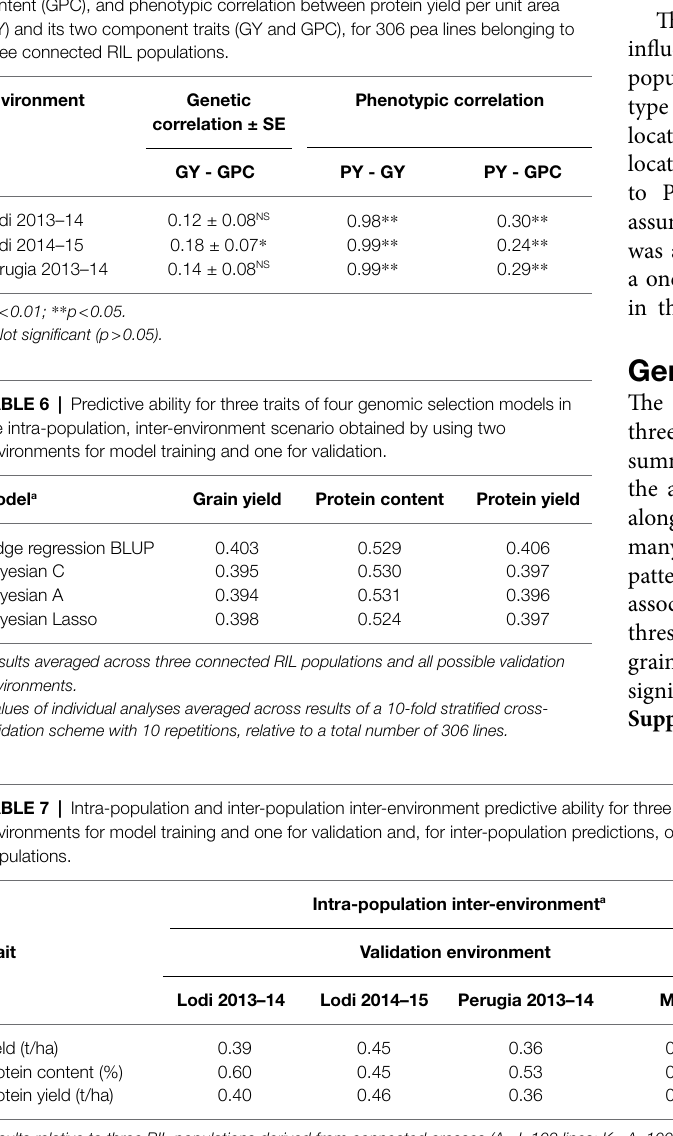
TABLE 5 | Genetic correlation between grain yield (GY) and grain protein content (GPC), and phenotypic correlation between protein yield per unit area (PY) and its two component traits (GY and GPC), for 306 pea lines belonging to three connected RIL populations. Environment